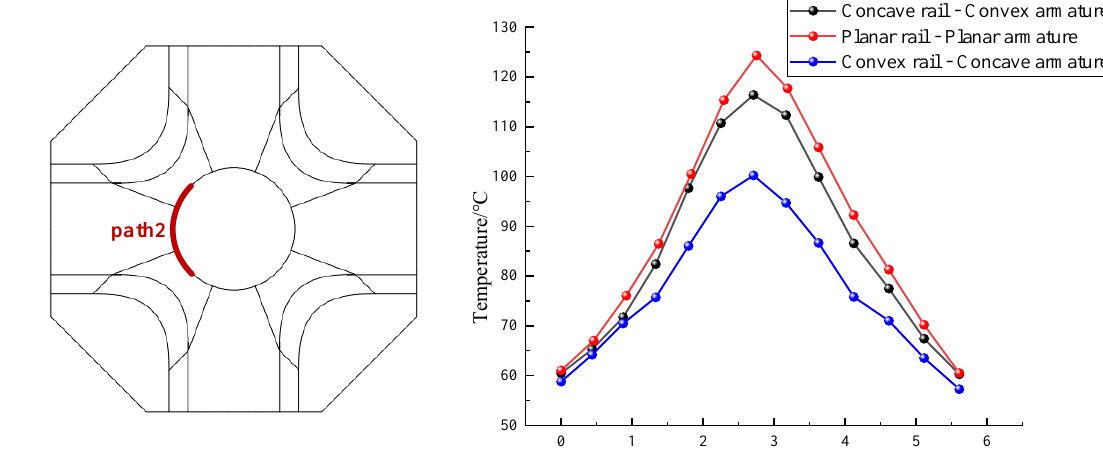
FIGURE 9. Schematic diagram of path 2 and temperature distribution As shown in the Fig. 9, the temperature on the edge path of the electromagnetic shield hole shows a symmetrical pattern, the highest temperature on the path of the concave rail-convex armature structure is 116.37℃, the highest temperature of the planar rail-plane armature structure is 124.32℃, and the highest temperature of the convex rail- concave armature structure is 100.2℃. The temperature of the convex rail-concave armature structure on the path is smaller than the other two structures, from the perspective of temperature field, the convex rail-concave armature structure can protect the munition better than the other two structures to avoid the risk of failure or premature detonation of the loaded munition due to high temperature [15].